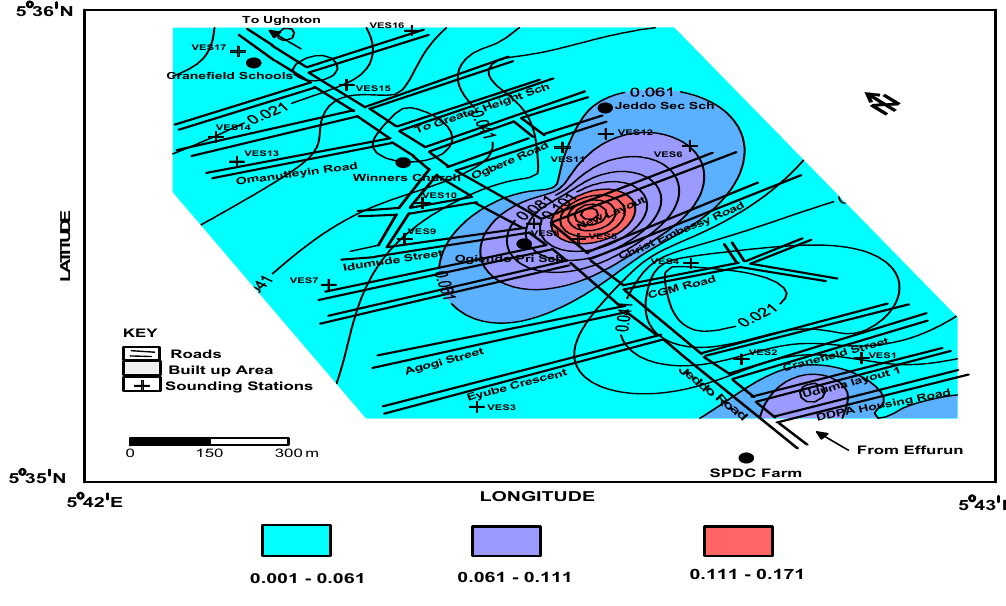
Figure 10. Map of the diagnostic factor.